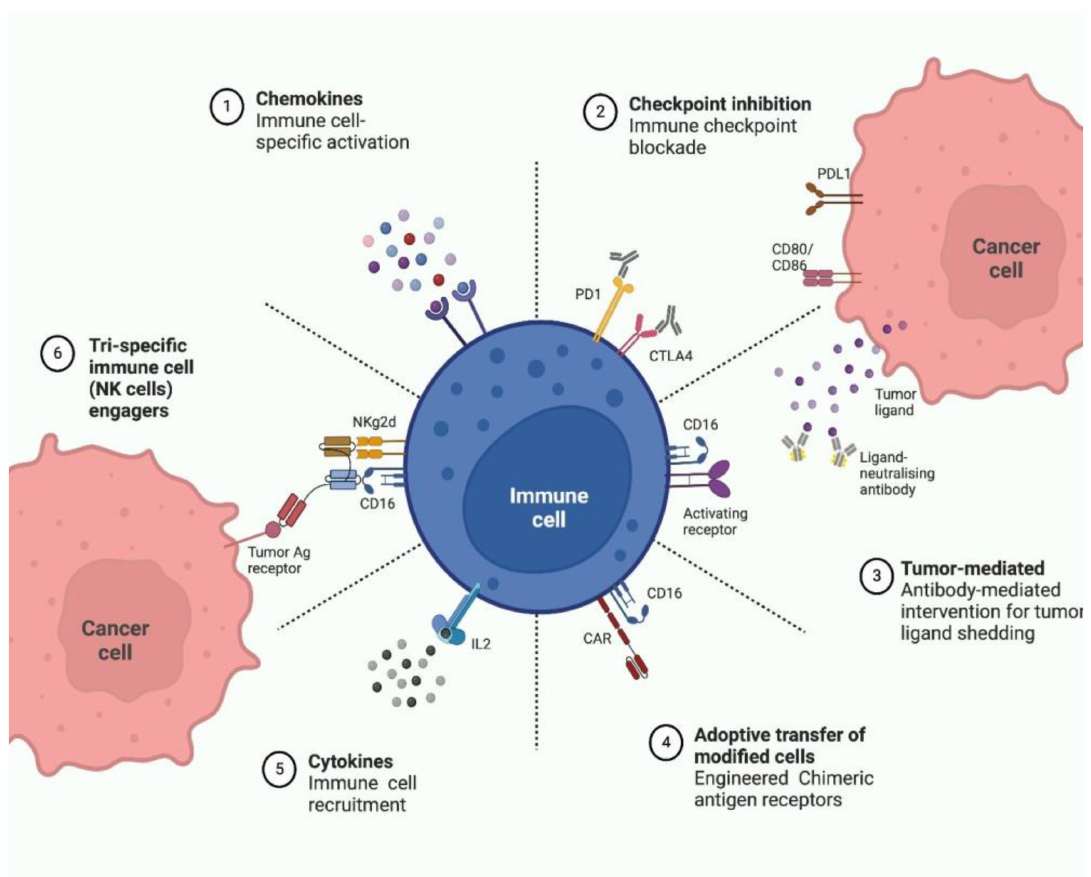
Figure 1. Approaches for immune cell-based cancer